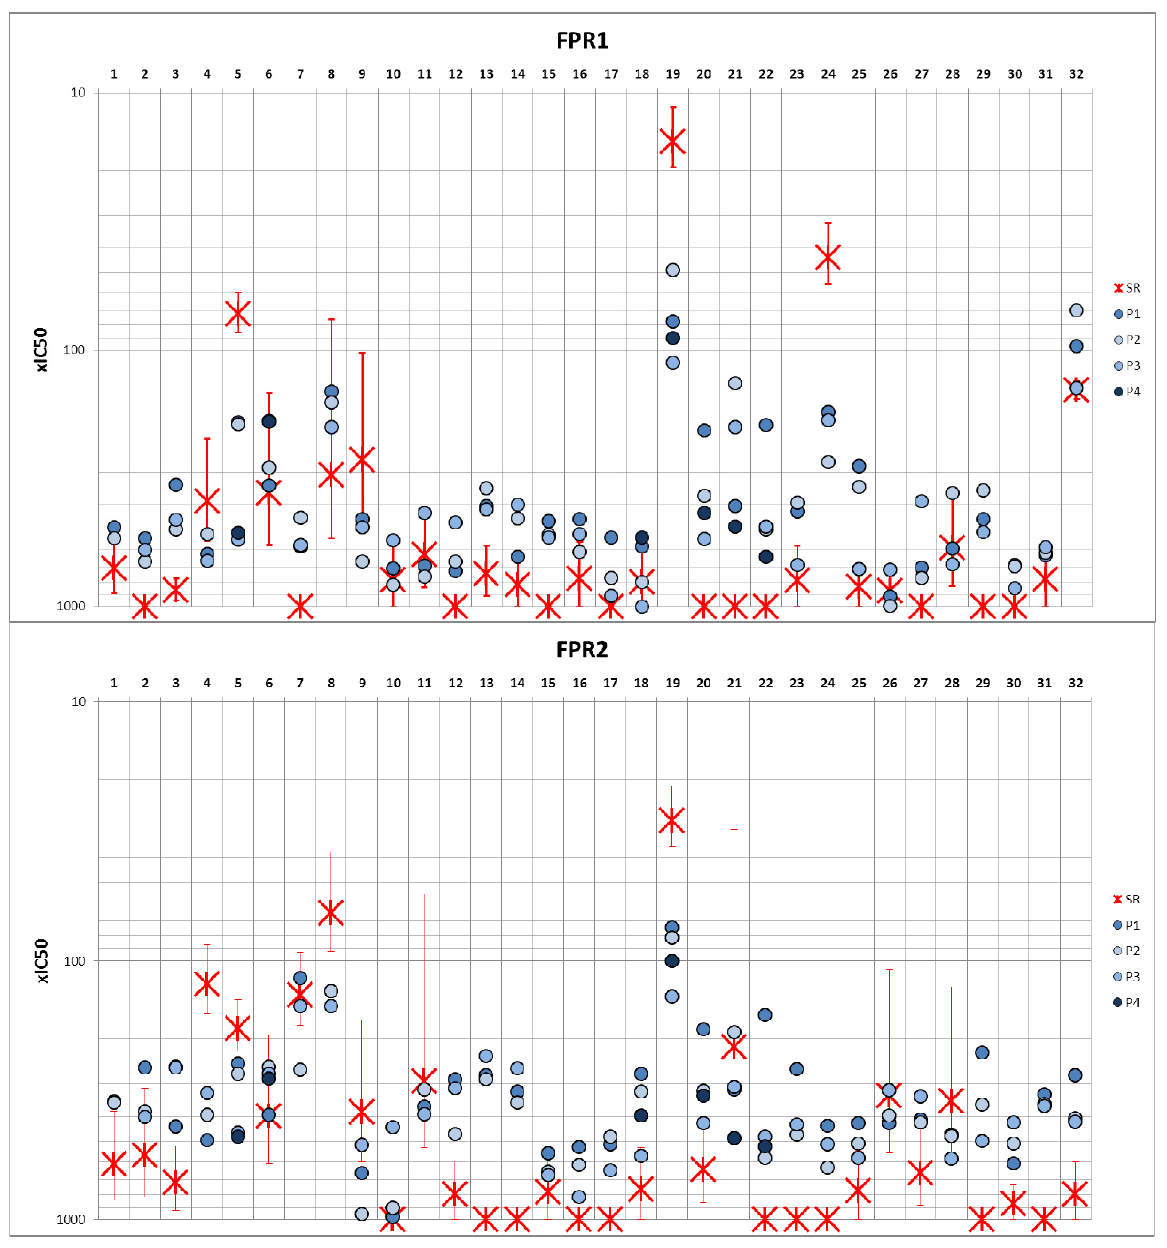
Figure 3. Comparison of the extrapolated scaffold ranking (cid:1835)(cid:1829)50 of each library (SR, shown as red stars), and the harmonic means of the extrapolated (cid:1835)(cid:1829)50(cid:1871) of each position of the positional scanning libraries samples (P1, P2, P3 and P4, shown as blue